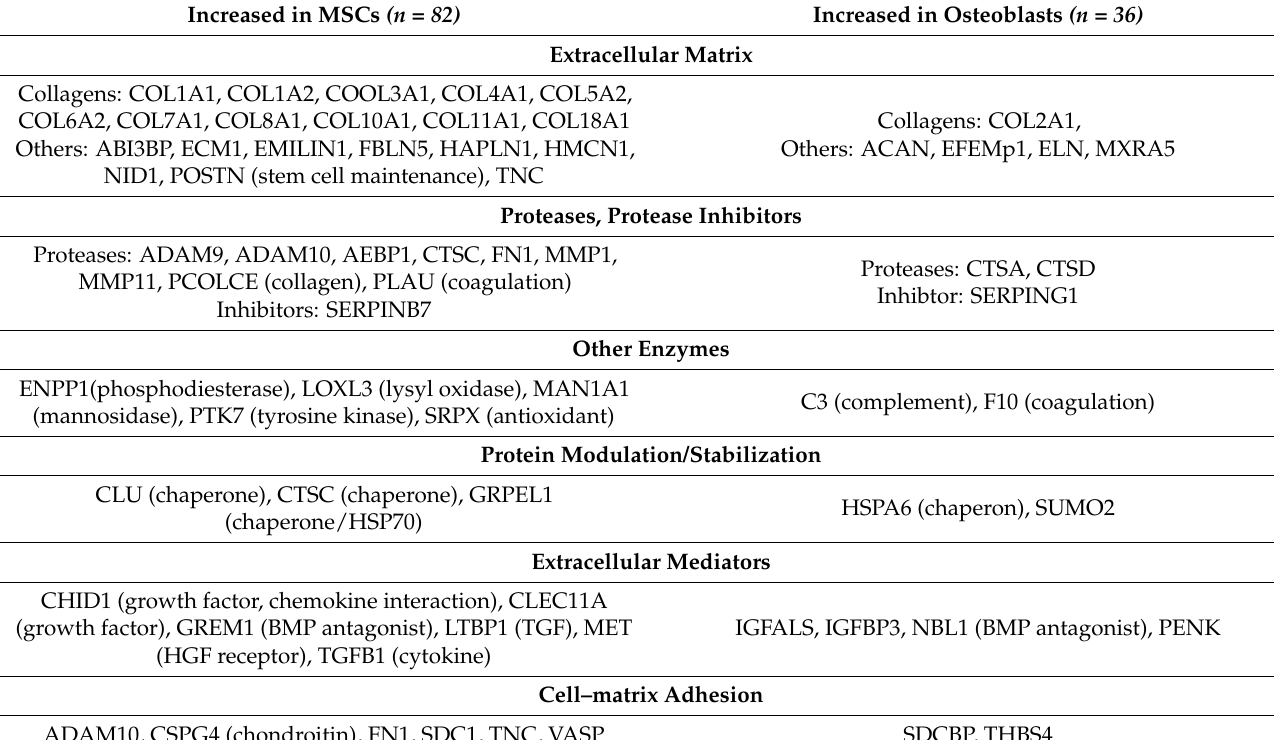
Table 3. An overview of released proteins showing significant differences between in vitro cultured MSC and osteoblasts. For more detailed information see Tables